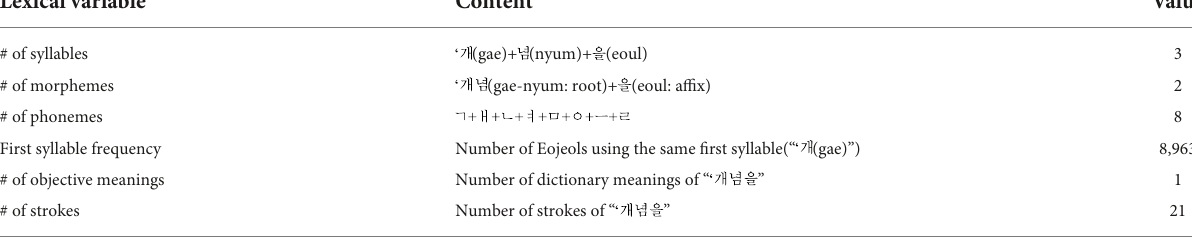
TABLE 1 Description of the lexical variables in experiment of this study.